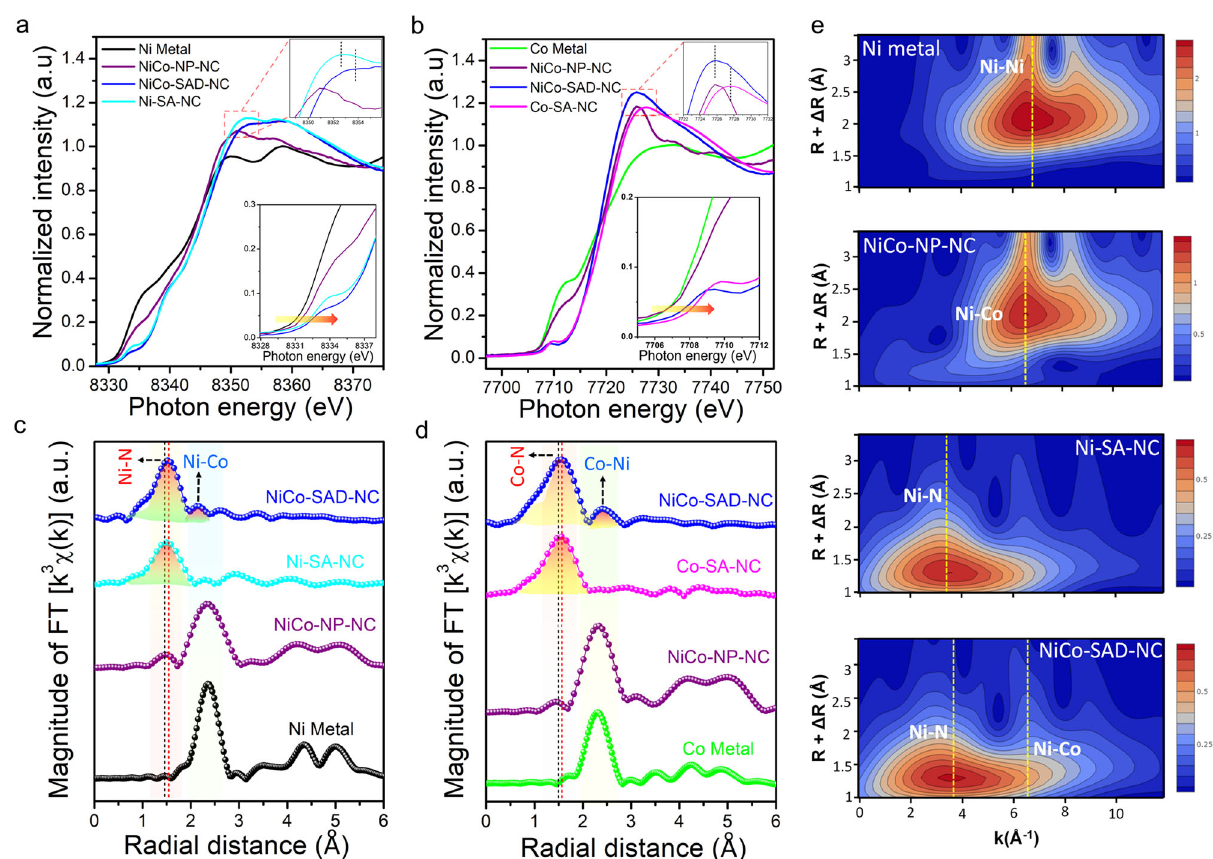
Fig. 4 Structural characterization by X-ray absorption spectroscopy. a , b Experimental Ni K-edge ( a ) and Co K-edge ( b ) XANES spectra of NiCo-SAD-NC with reference samples. The inset zooms in over the near edge (bottom) and white line (top) feature. c , d Experimental Ni K-edge ( c ) and Co K-edge ( d ) FT-EXAFS spectra of NiCo-SAD-NC along with reference samples. e WT-EXAFS of NiCo-SAD-NC along with reference samples at Ni